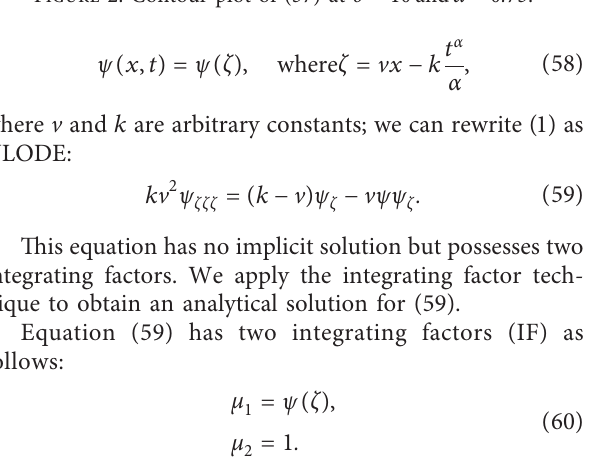
Figure 2: Contour plot of (57) at σ � 10 and α � 0 . 75.